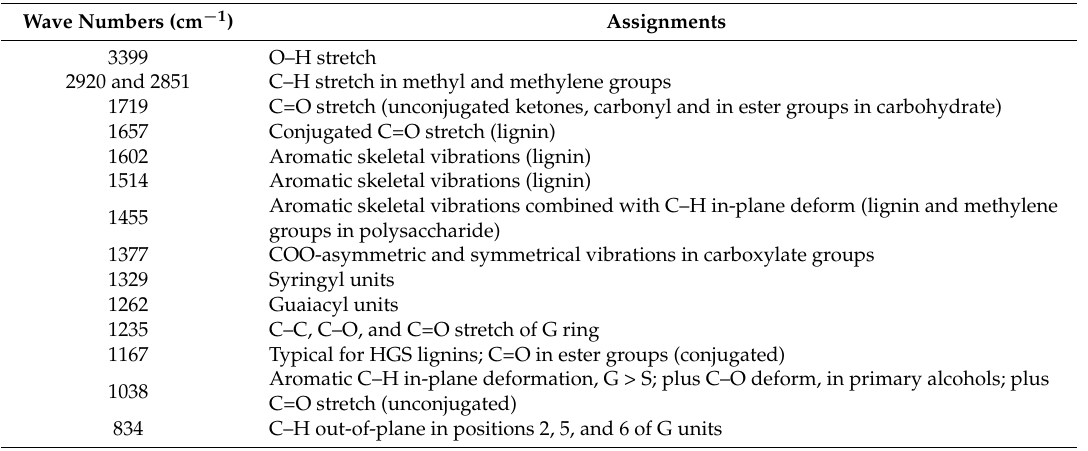
Table 3. Assignments of the FT-IR spectra of the LCC